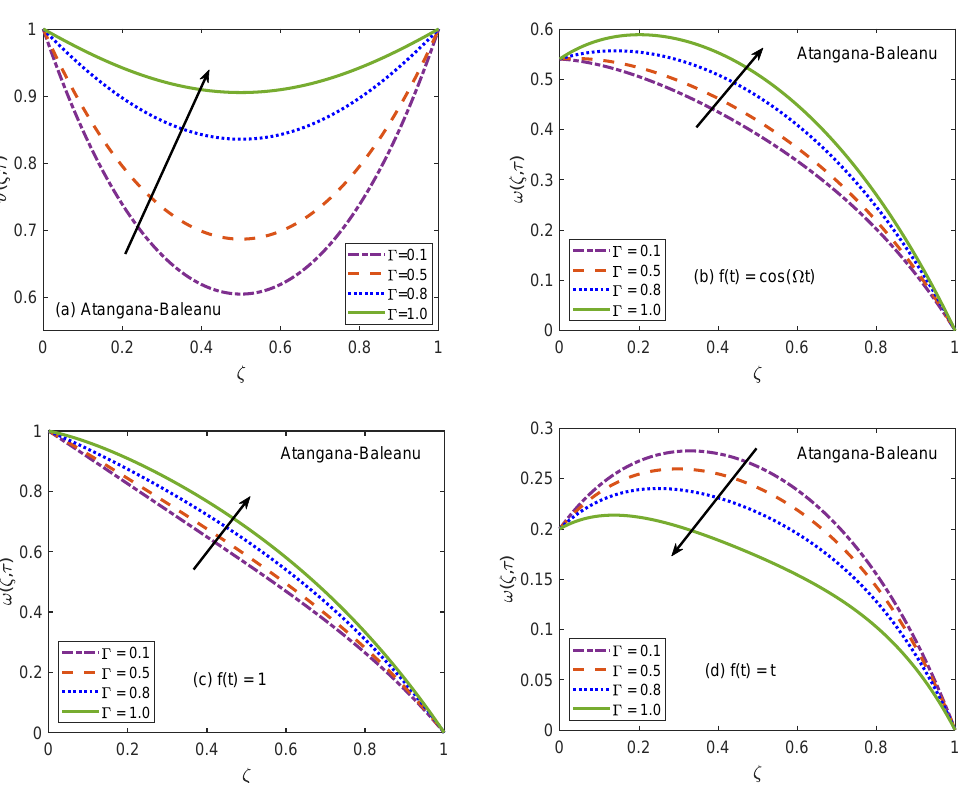
Figure 6. Temperature and velocity patterns of AB model for variation of Γ .